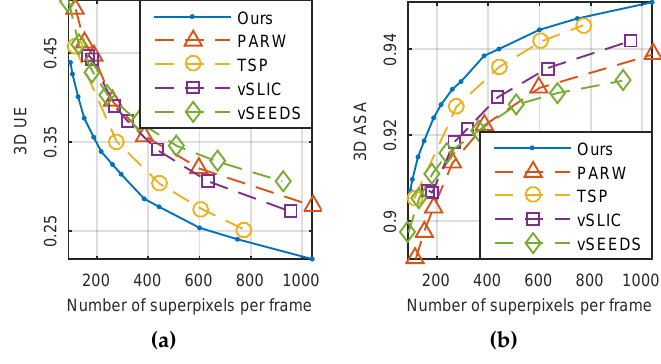
Figure 6. Results of 3D metrics. ( a ) 3D UE; ( b ) 3D